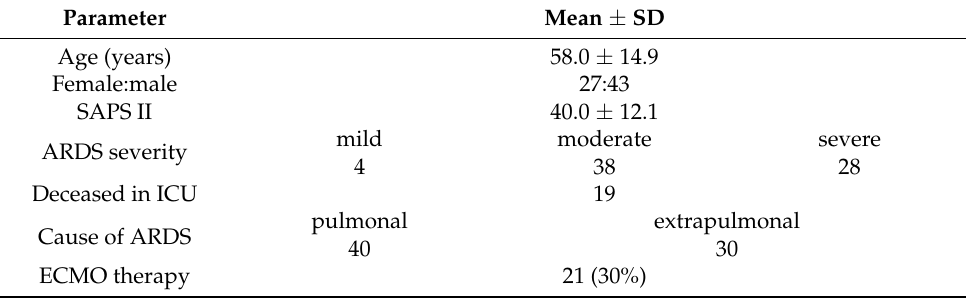
Table 1. Subject